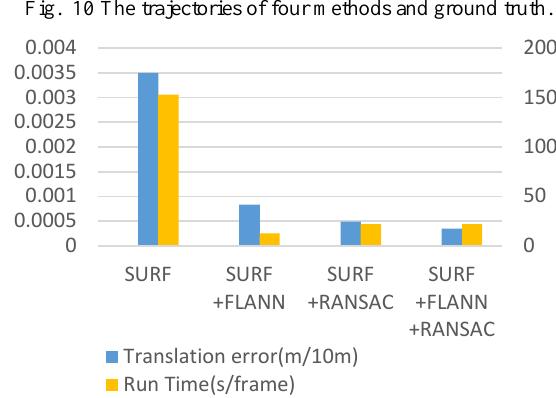
Fig. 10 The trajectories of four methods and ground truth.